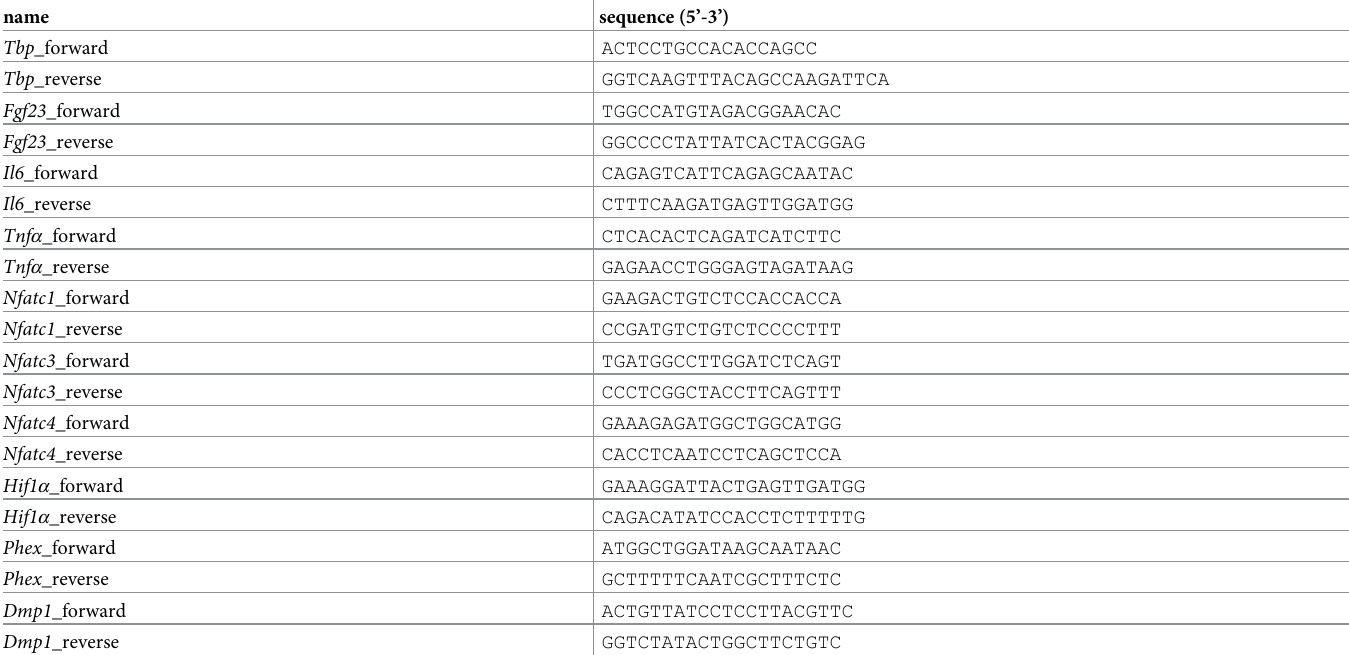
Table 2. Primer sequences used for